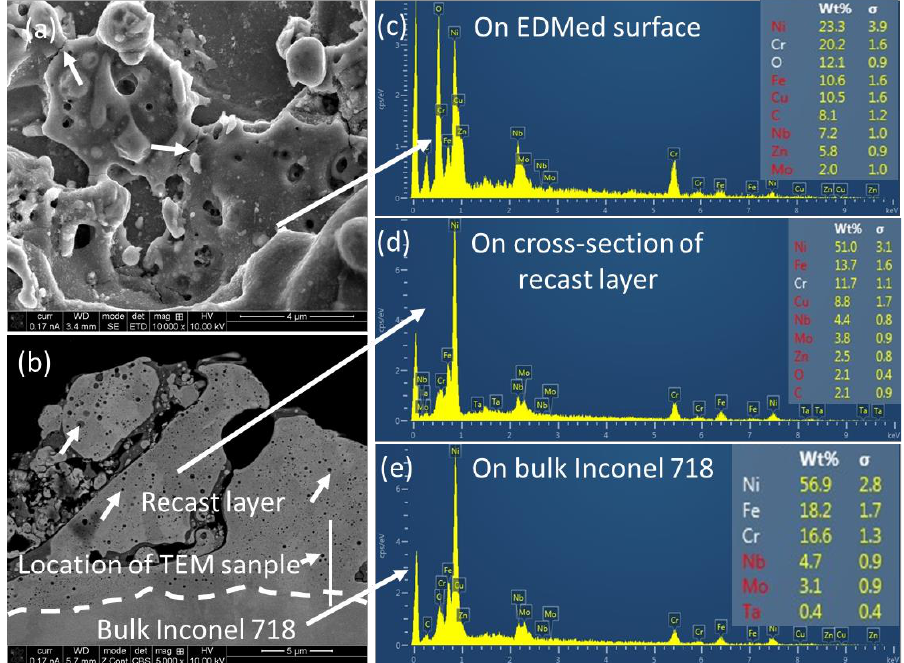
Figure 3. Representative features on the machined surface of Inconel 718 after WEDM on ( a ) cylindrical surface and ( b ) cross-together with energy-dispersive X-ray spectroscopy (EDX) spectra on ( c ) cylindrical surface, ( d ) cross-section, and ( e ) bulk material.